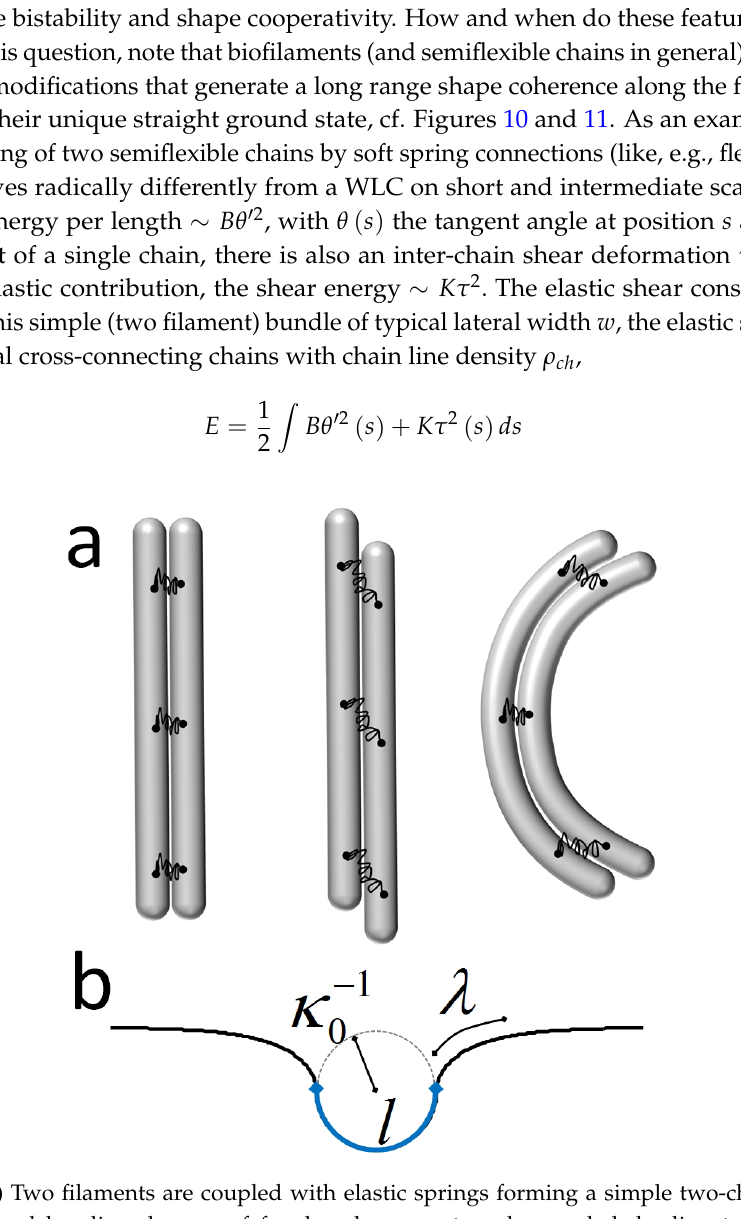
Figure 10. ( a ) Two filaments are coupled with elastic springs forming a simple two-chain bundle; ( b ) the shear and bending degrees of freedom become strongly coupled, leading to long-range deformation effects. An arc formed in the region of length l (blue line) around the origin induces two counter-arcs with opposite curvature in its next proximity. The deformations are screened and vanish only at length scales longer than the elastic screening length λ